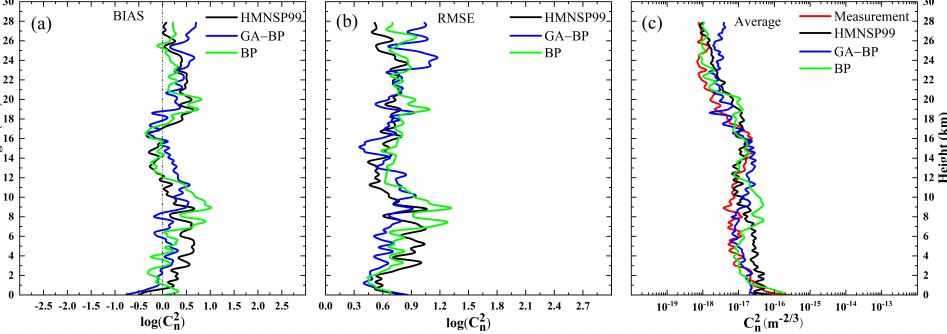
Figure 10. Statistical results of the C 2 n ( h ) profiles between the GA-BP, BP and HMNSP99 models in the night. ( a ) BIAS. ( b ) RMSE. ( c ) Average C 2 n ( h )